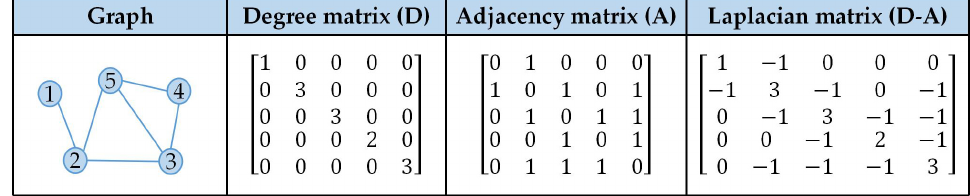
Figure 10. The Laplacian matrix.